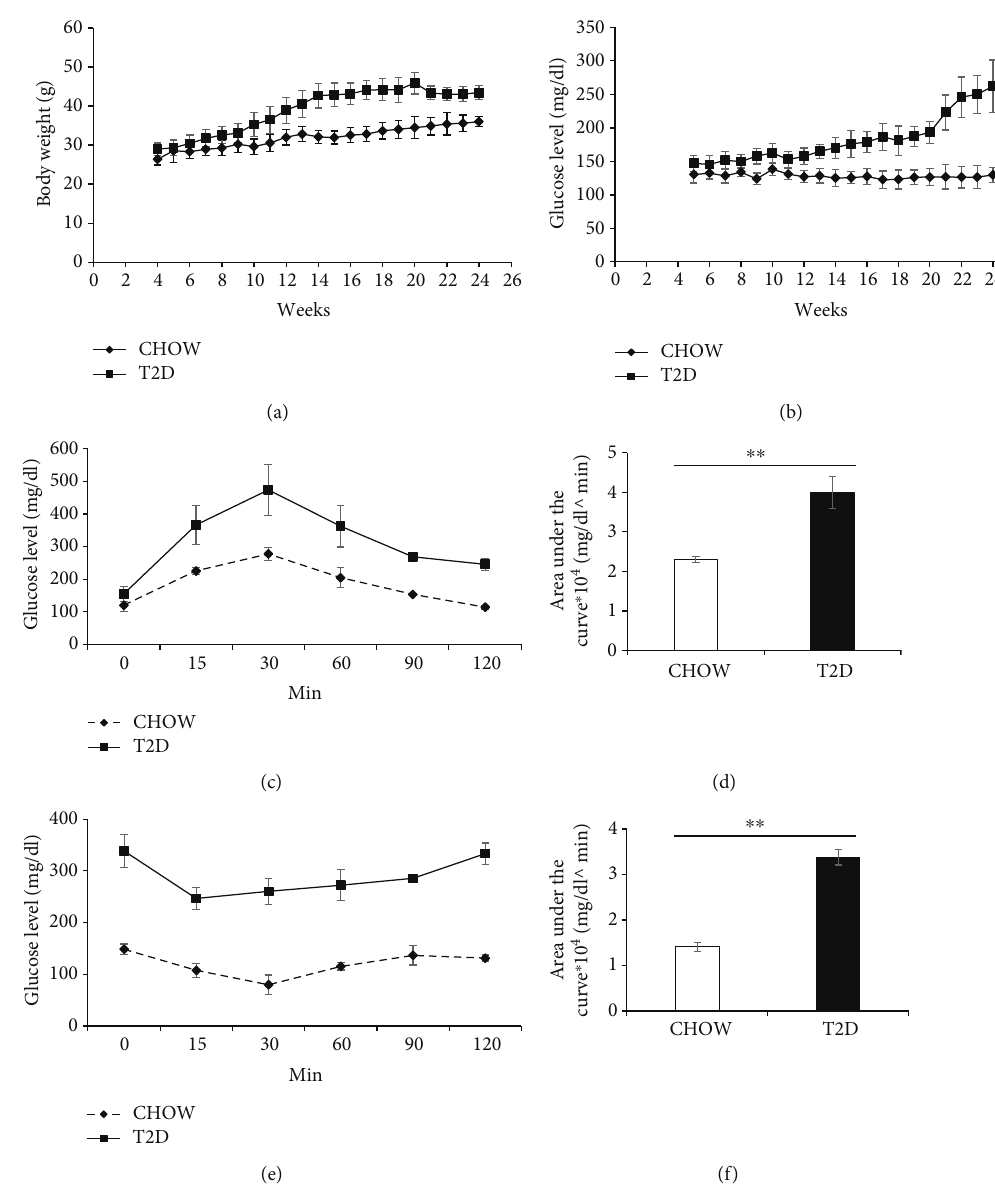
Figure 1: Generation of T2D mice by HFD combined with multiple low-dose STZ injections. (a) Changes in body weights of chow (normal) mice ( n = 30 ) and T2D mice ( n = 40 ). (b) Blood glucose levels in chow and T2D mice. (c) Blood glucose levels of chow and T2D mice during the IPGTT ( n = 4 mice per group). (d) Area under the curve during the IPGTT. (e) Blood glucose levels of chow and T2D mice during the ITT ( n = 4 mice per group). (f) Area under the curve during an ITT. The bars are mean ± SD . ∗ P < 0 : 05 ; ∗∗ P < 0 : 01